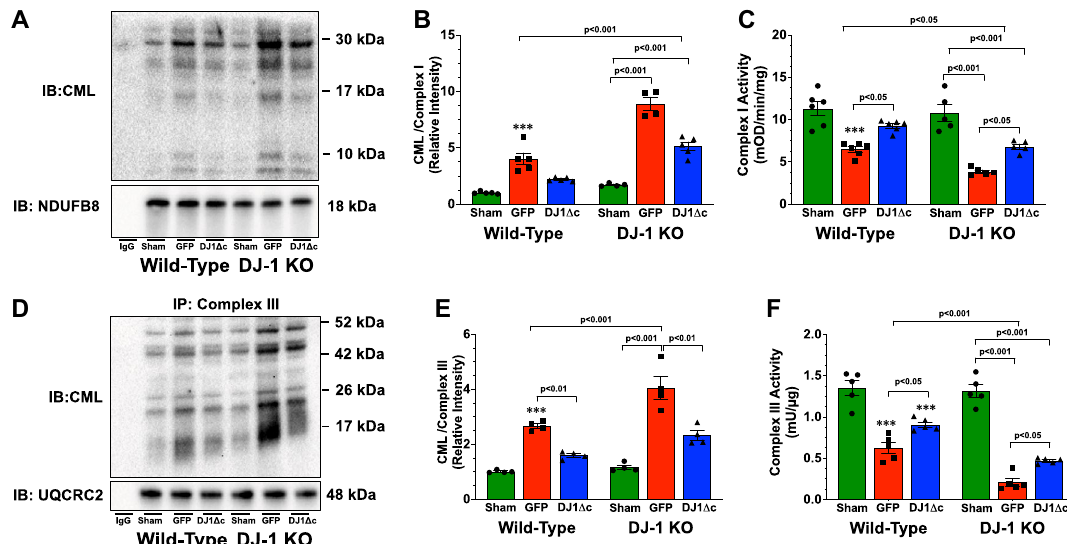
Figure 4. Overexpression of Cleaved form of DJ-1 attenuates ischemia–reperfusion induced glycation of complex I and complex III. ( A ) Immunoblots and ( B ) analysis from immunoprecipitation experiments examining the glycative status of complex I of the mitochondria electron transport chain. ( C ) Complex I activity. (D ) Immunoblots and ( E ) analysis from immunoprecipitation experiments examining the glycative status of complex III of the mitochondria electron transport chain. ( F ) Complex III activity. Measurements were performed in samples collected at 3 days of reperfusion from wild-type and DJ-1 KO mice administered AAV9- GFP (GFP) or AAV9-DJ1Δc (DJ1Δc). Values are means ± SEM. 4–6 samples per group. Two-way ANOVA with a Tukey test as the posthoc analysis. *** p < 0.001 vs. wild-type Sham. IP immunoprecipitation. IB immunoblot.